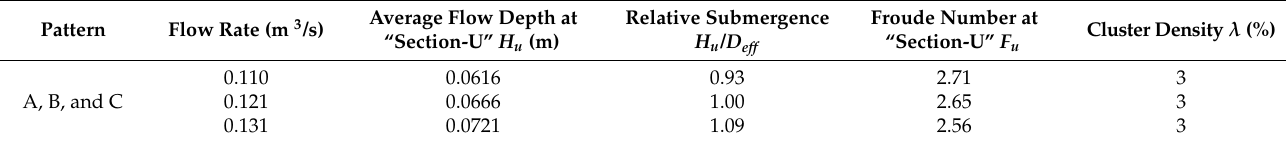
Table 2. Details of various experimental